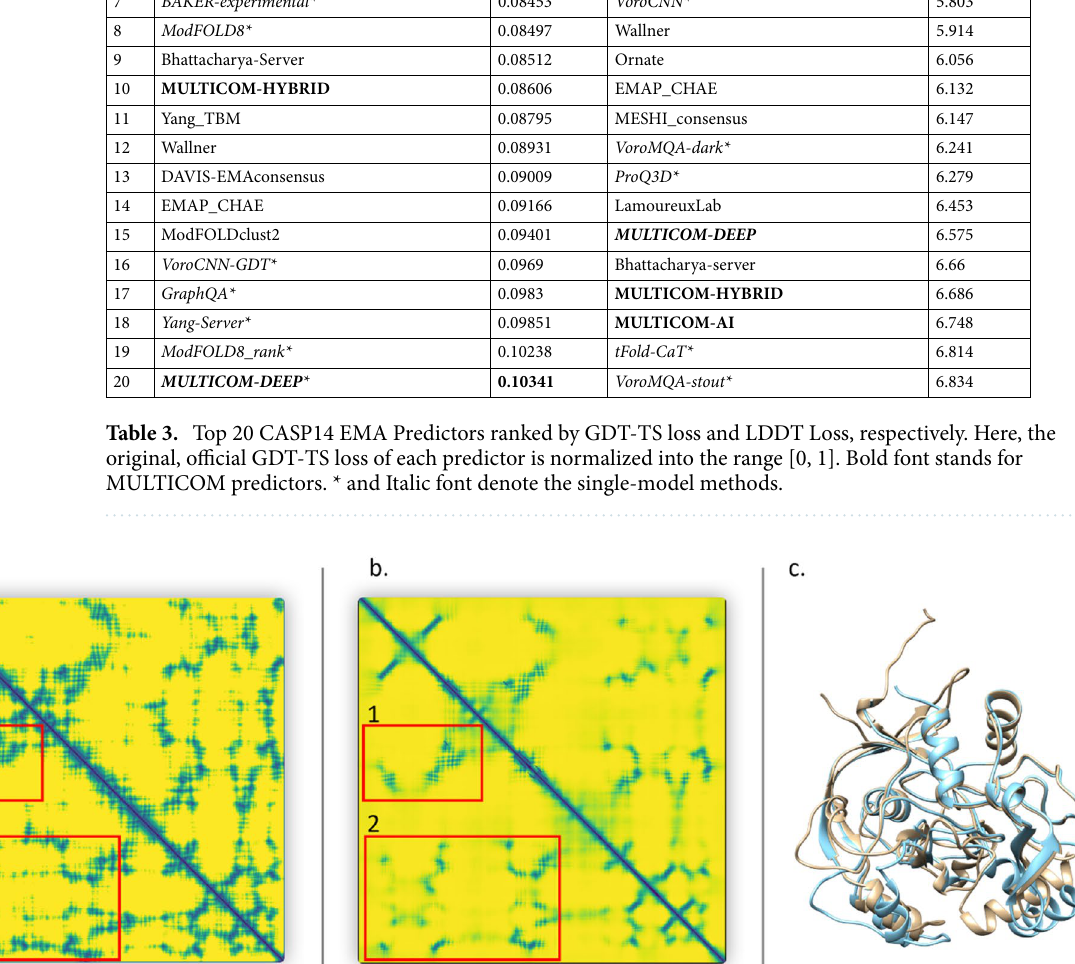
Figure 5 is the per-target comparison of the GDT-TS scores of the truly best structural model, the top model selected by a multi-model method—MULTICOM-CONSTRUCT and a single-model method—MULTICOM- DEEP. On most targets (33 targets), the performance of MULTICOM-CONSTRUCT is better than MULTI- COM-DEEP. The biggest performance gap occurs on T1042, for which the top model selected by MULTICOM- CONSTRUCT has a true GDT-TS score of 0.5346, four times more than 0.1289 of MULTICOM-DEEP. On 17 targets, MULTICOM-CONSTRUCT and MULTICOM-DEEP have the same performance. Comparison with other CASP14 EMA predictors. CASP14 released the whole server’s overall and per-target performance in ranking structural models. Table 3 is the summary of the GDT-TS loss and the Local Distance Difference Test (LDDT) 47 loss of top 20 out of 68 predictors that predicted the quality of the models of most CASP14 targets. LDDT is a superposition-free score measuring the local distance difference among all